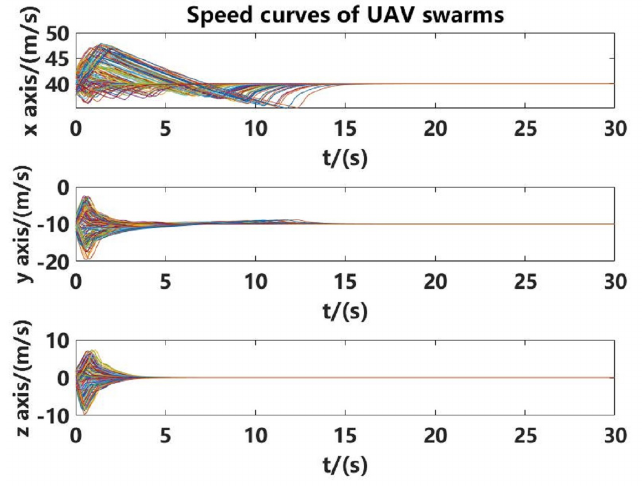
Figure 19. Speed curves of UAV swarms.